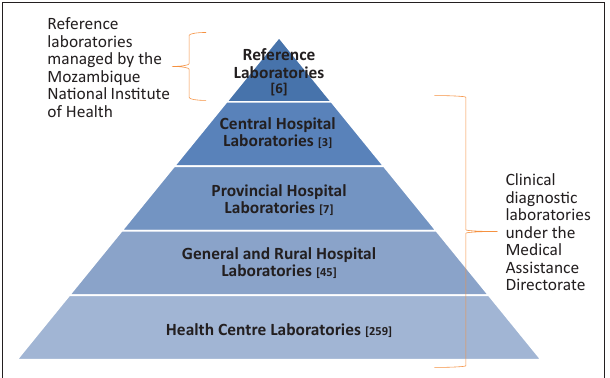
FIGURE 1: Tiered Ministry of Health laboratory network in